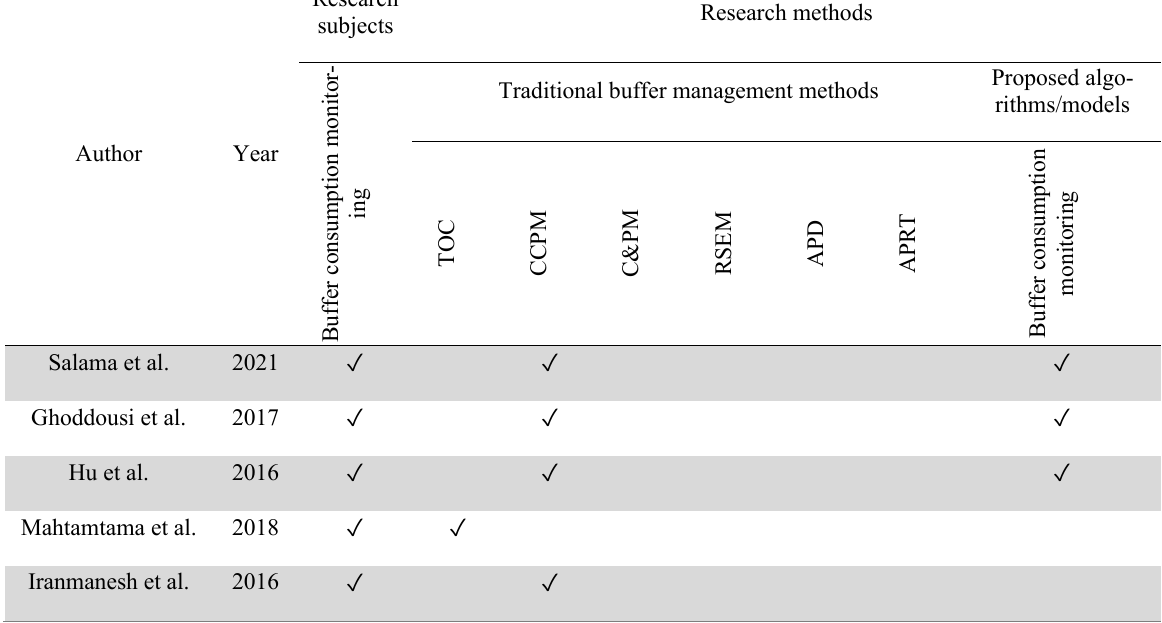
Project buffer consumption monitoring: Traditional buffer management